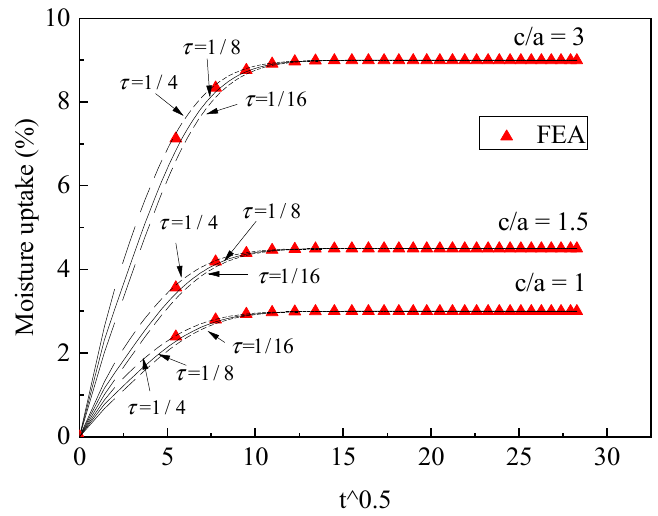
Figure 10. Validation of the three-phase diffusion model, D 1 > D 2 , c / a ≥ 1. From the analysis above, the conclusion was draw that if τ = 1/8, the theoretical model will agree with FEA data for both cellulose fiber and synthetic fiber cases. The approximate equivalence represents the right balance between the minimum equivalence and maximum equivalence, τ = 1/8, which approximately simulated the fast diffusion and slow diffusion in part